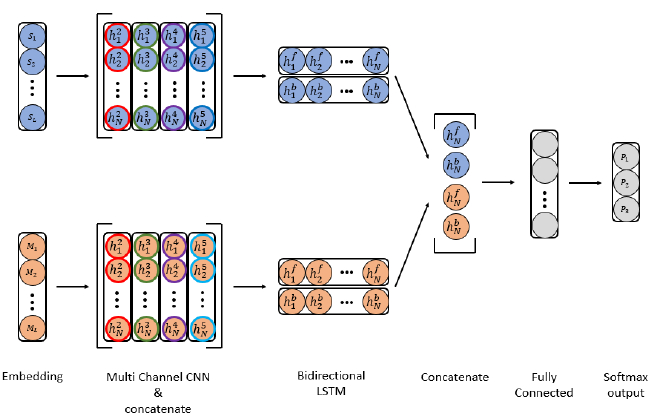
Figure 1. Word spacing correction model architecture.